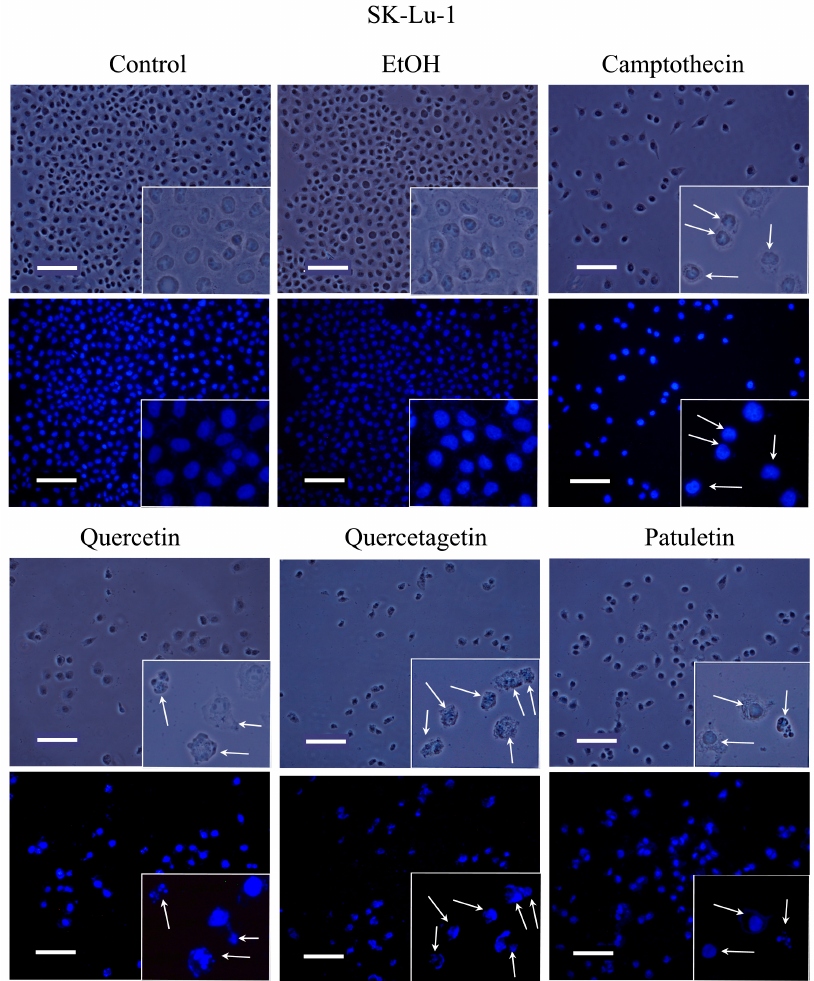
Figure 8. Morphology and DAPI staining. view of SK-Lu-1 cultures, were exposed to quercetin, quercetagetin and patuletin at the aforementioned IC 50 values. Camptothecin was used as a positive control for apoptosis. The phase-contrast images evidence cellular shapes under the different experimental conditions. The control and EtOH cells had extended cytoplasm with chromatin distributed in the nuclear space, as shown by the fluorescent distribution of DAPI. After treatment, both the cytoplasm and nucleus were contracted, and several apoptotic bodies were visible (arrows), Scale bars 100 microns.